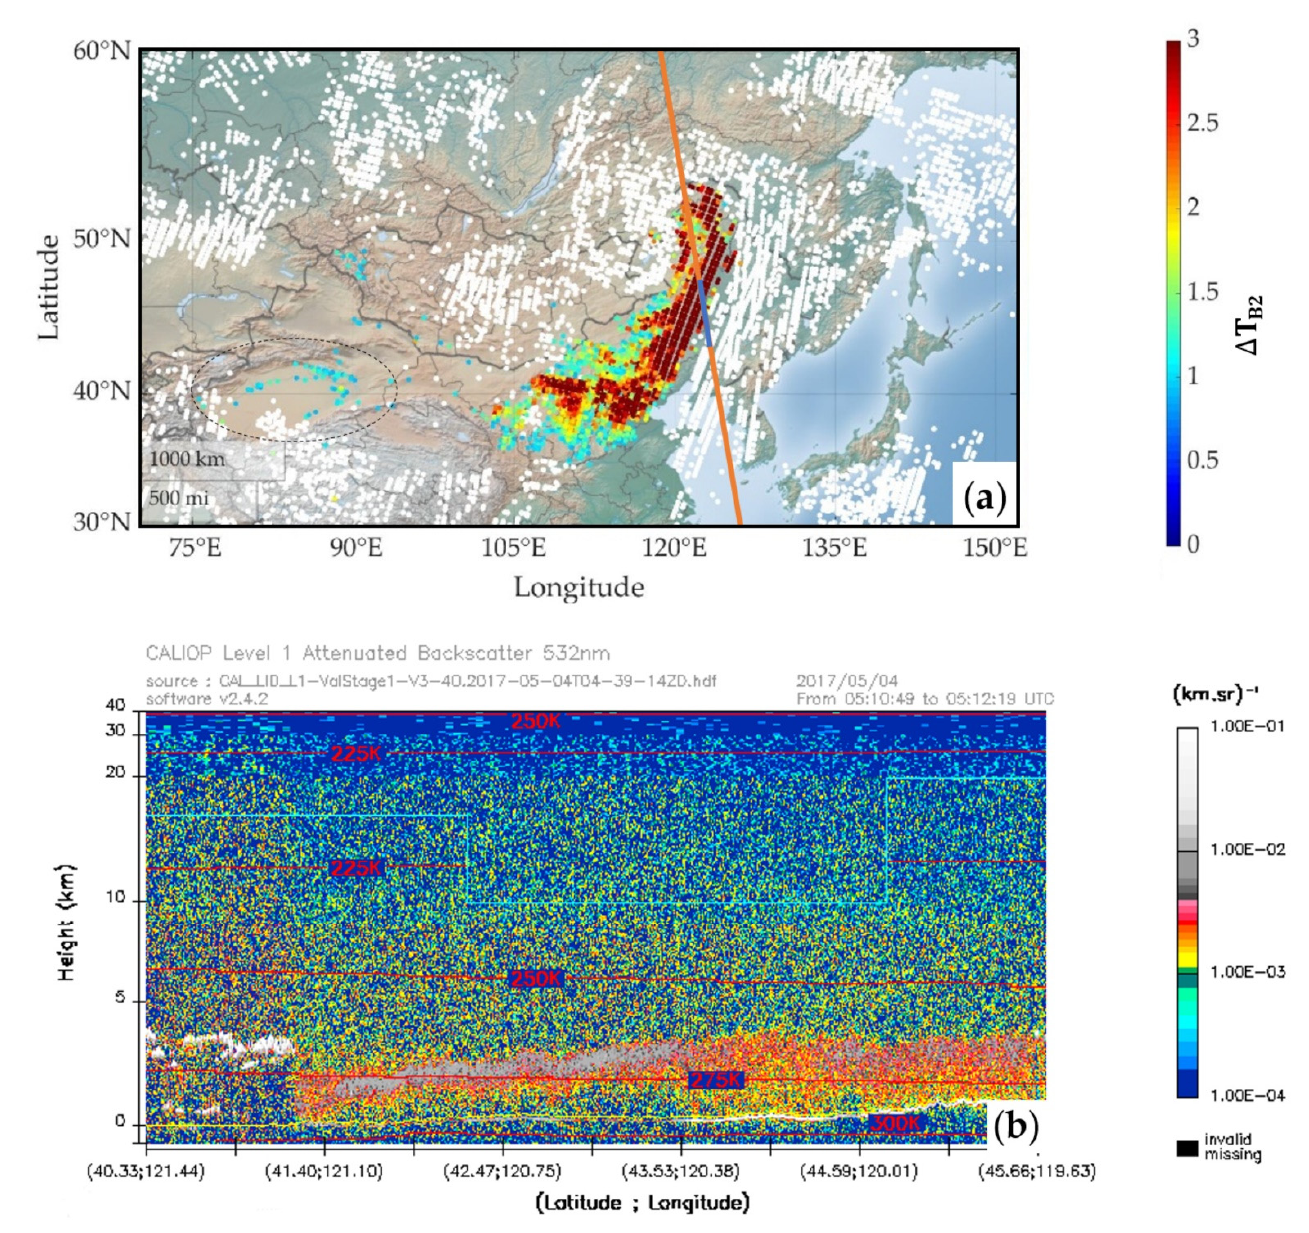
Figure 9. ( a ) The difference in the brightness temperature of the IASI dust selection after LSE optimization during the dust storm on 4 May 2017, in daytime. The dashed black circles present the removed false aerosol detection region. The orange line is the CALIOP orbit track, and the blue line is the CALIOP viewing section; ( b ) CALIOP-attenuated backscatter at 532 nm (www.icare.univ-lille.fr, accessed on 27 November 2021).